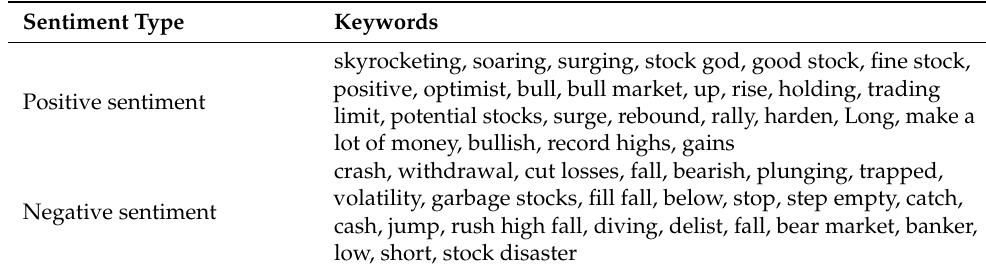
Table A1. Keywords of the Baidu index in